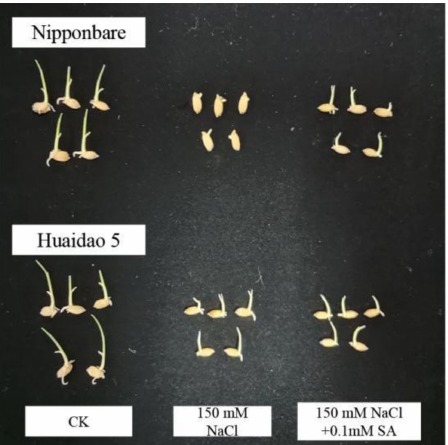
Figure 2. Effects of NaCl and SA on root and shoot growth of Nipponbare and Huaidao